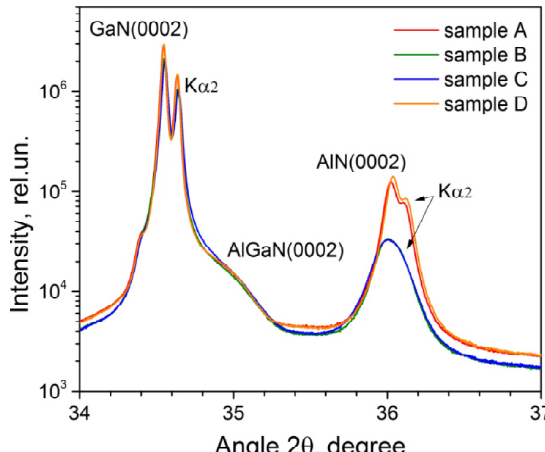
Fig. 8. Room temperature photoluminescence spec- tra of the